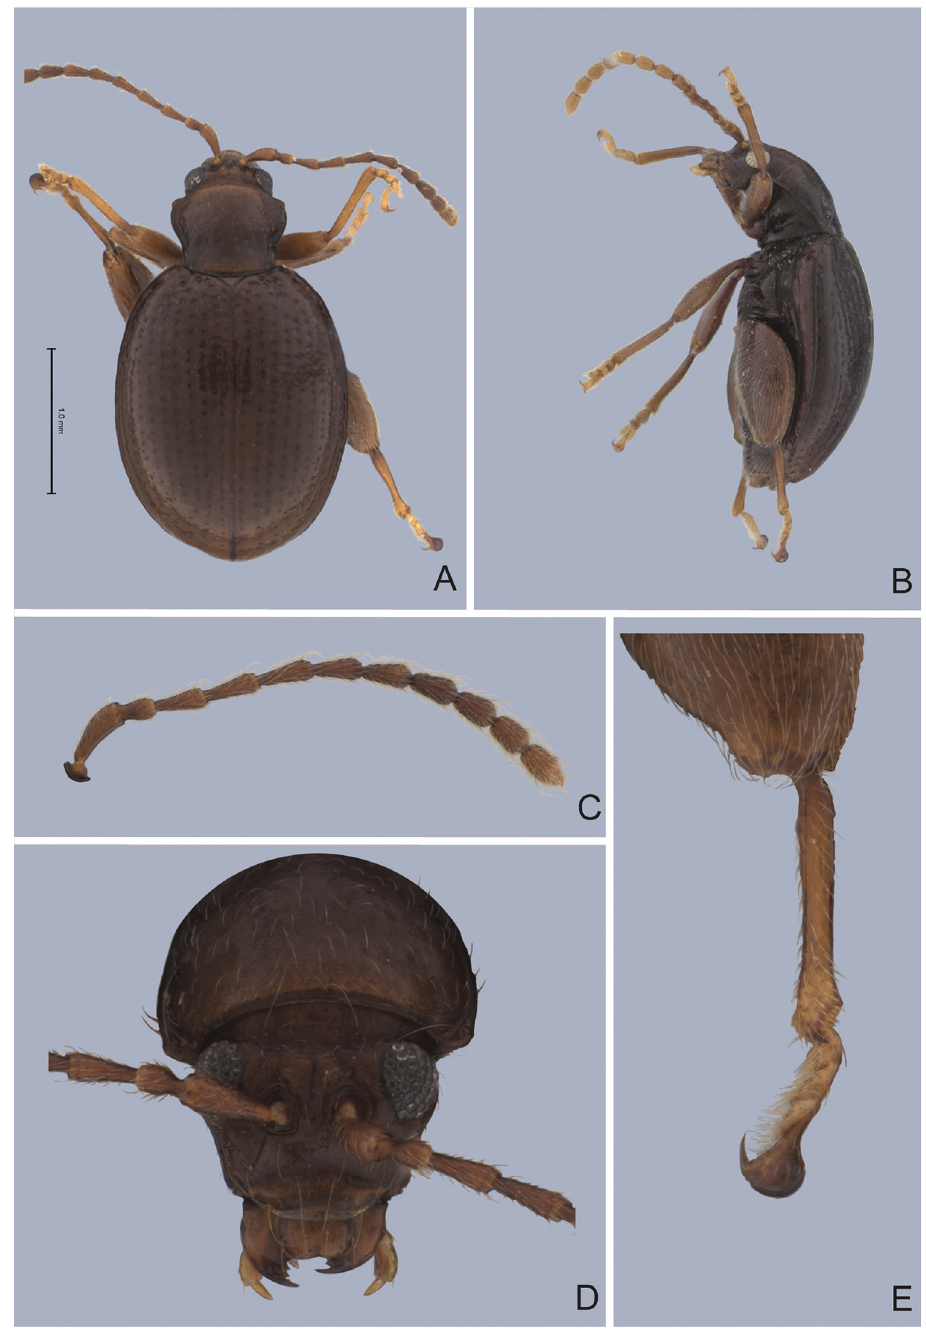
Figure 7. Andersonoplatus castaneus . A Habitus dorsal B Habitus lateral C Antenna D Head, frontal view E Hind